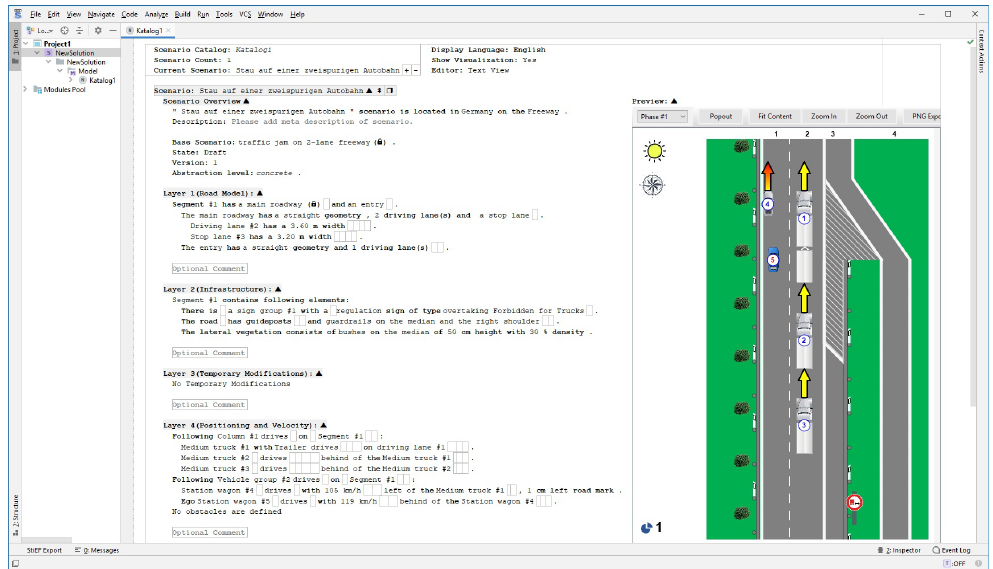
Figure 3. Example of scenario description using stiEF . From